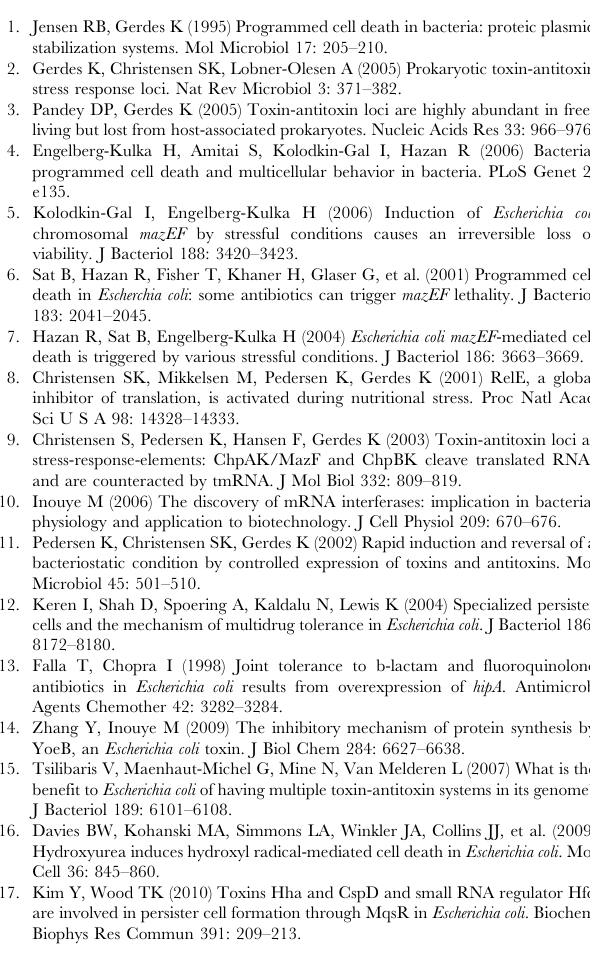
Figure S3 Effect of accumulated UV irradiation energy on differential killing of wildtype and a ndoA deficient mutant. Percent survival of wild-type strain (BD630, filled symbols) and its D ndoA mutant (3169, open symbols) received low (0.14 mW/cm 2 , diamonds), high (0.4 mW/cm 2 , circles), or moderate (0.2 mW/cm 2 , triangles) UV irradiation intensity, as displayed in Figures 3A–3C, is plotted as a function of accumulated energy (milliJoule/cm2) in a single panel to show that bacterial killing correlates with accumulated radiation